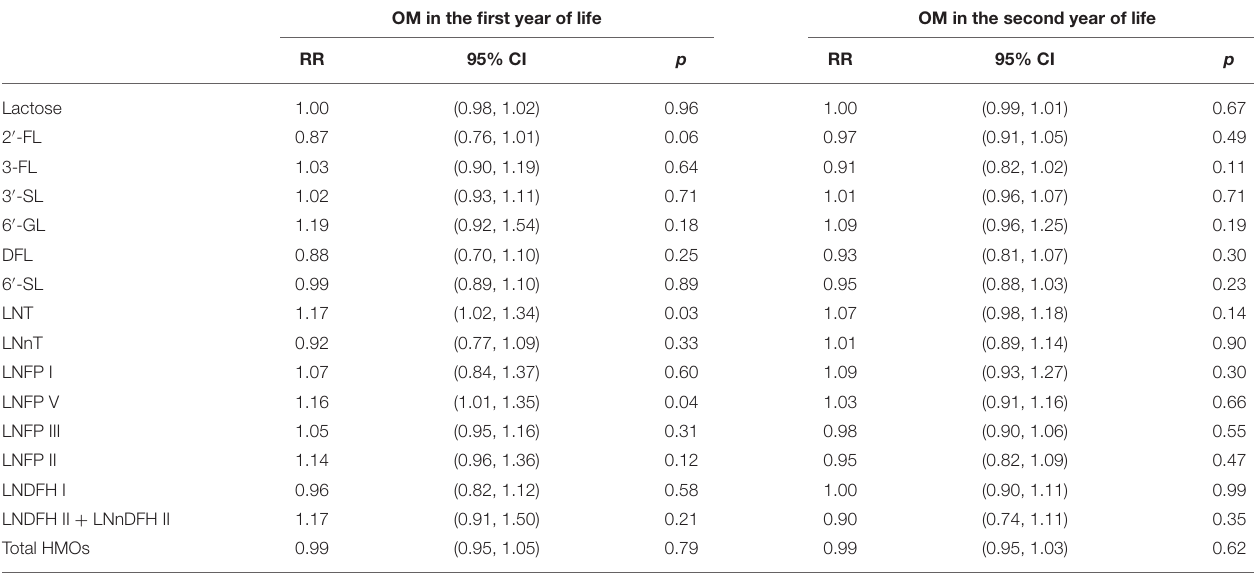
LNDFH I 0.96 (0.82, 1.12) 0.58 1.00 (0.90, 1.11) 0.99 LNDFH II LNnDFH II 1.17 (0.91, 1.50) 0.21 0.90 (0.74, 1.11) 0.35 + Total HMOs 0.99 0.62